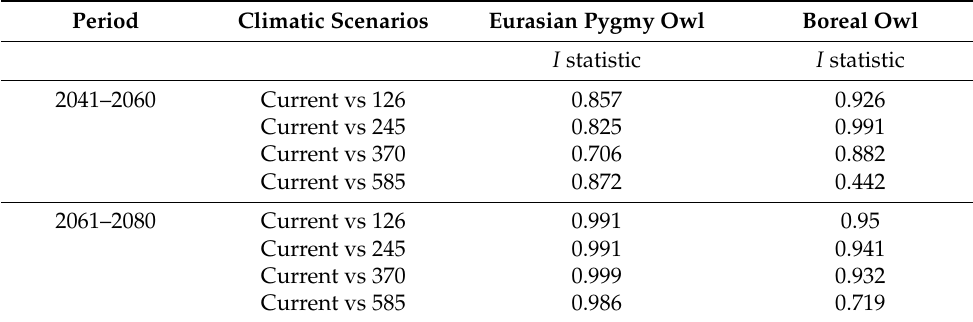
Figure 4. Type 1—in situ refugia for Boreal Owl ( Aegolius funereus ) and for Eurasian Pygmy Owl in the Balkan Peninsula in 2041–2060 and 2061–2080. Colour coding: grey = no refugia; blue = refugia for Boreal Owl; purple = refugia for Eurasian Pygmy Owl.